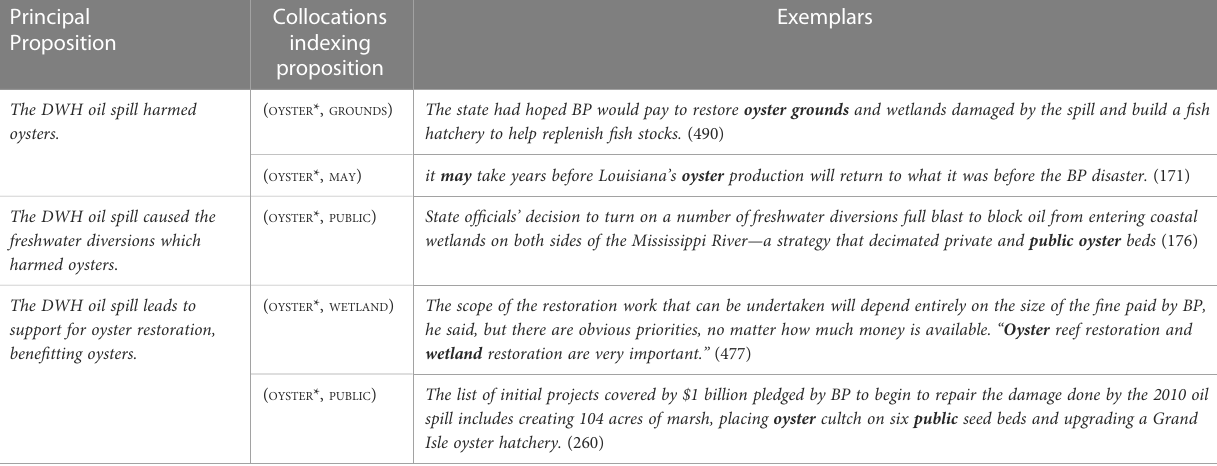
TABLE 5 Collocations and text exemplars for principal propositions relating DWH to oysters in post-DWH time span.